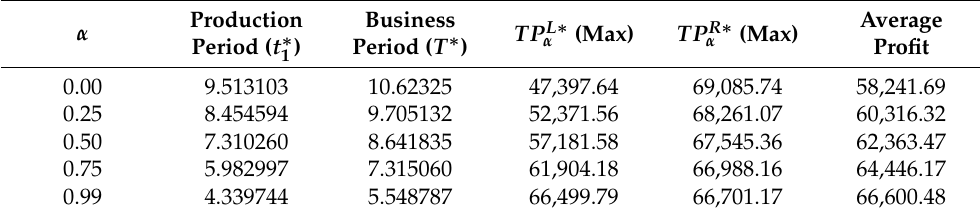
Table 4. Optimum results of Example 1 for maximizing both TP L α and TP R α .